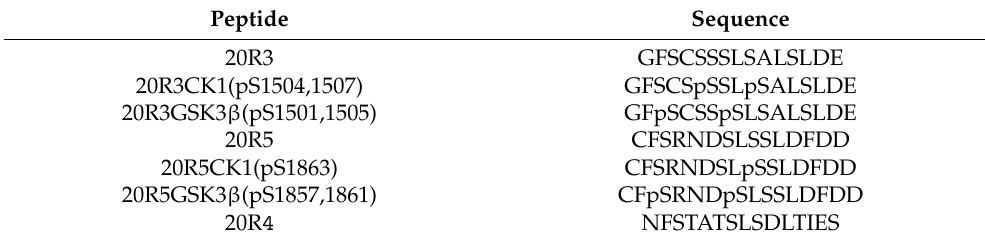
Table 1. The 20R peptides and their phosphorylation